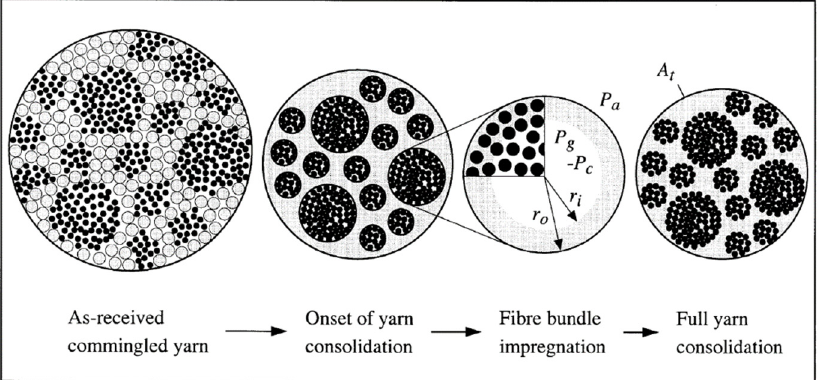
Figure 15. Representative commingled yarn cross-section and assumed consolidation mechanism. Reprinted with permission from Reference [64].